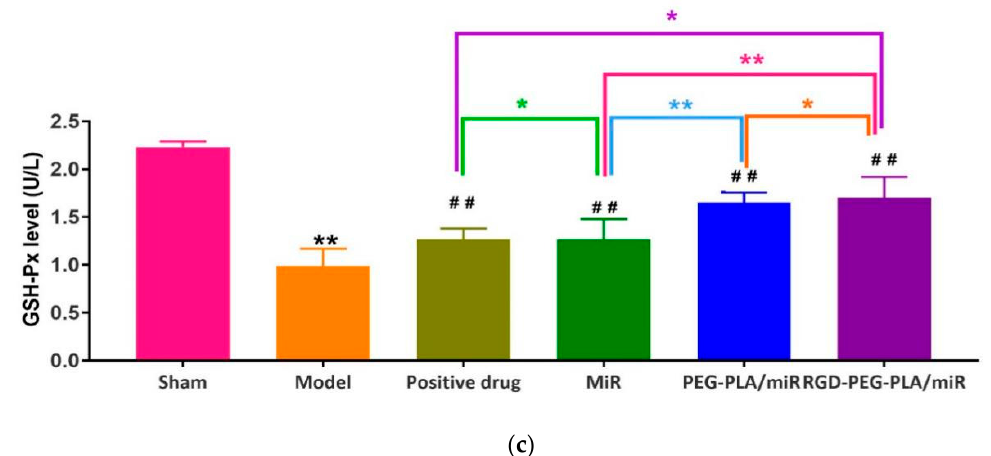
Figure 8. The levels of ( a ) superoxide dismutase (SOD), ( b ) malondialdehyde (MDA), and( c ) glutathione peroxidase (GSH-Px) in six groups of rats (mean ± SD, n = 6). Compared with the sham group, the difference was statistically significant (** p < 0.01). Compared with the model group, the difference was statistically significant ( # p < 0.05, ## p < 0.01). The color asterisks indicate significant differences between the two groups, * p < 0.05 and ** p < 0.01.